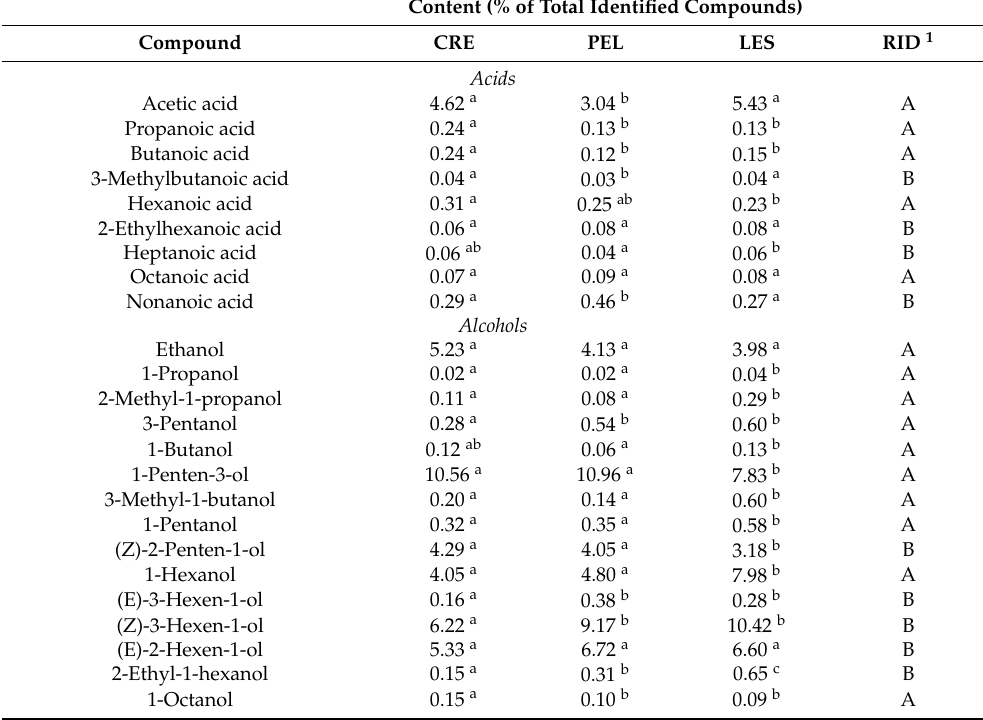
Table 1. Volatile composition of EVOOs according to the growing area of olive tree. The values represent the mean content (%) of the samples in each region. Data in the same row with different lowercase letters differ significantly ( p < 0.05). CRE: Crete; PEL: Peloponnese; LES: